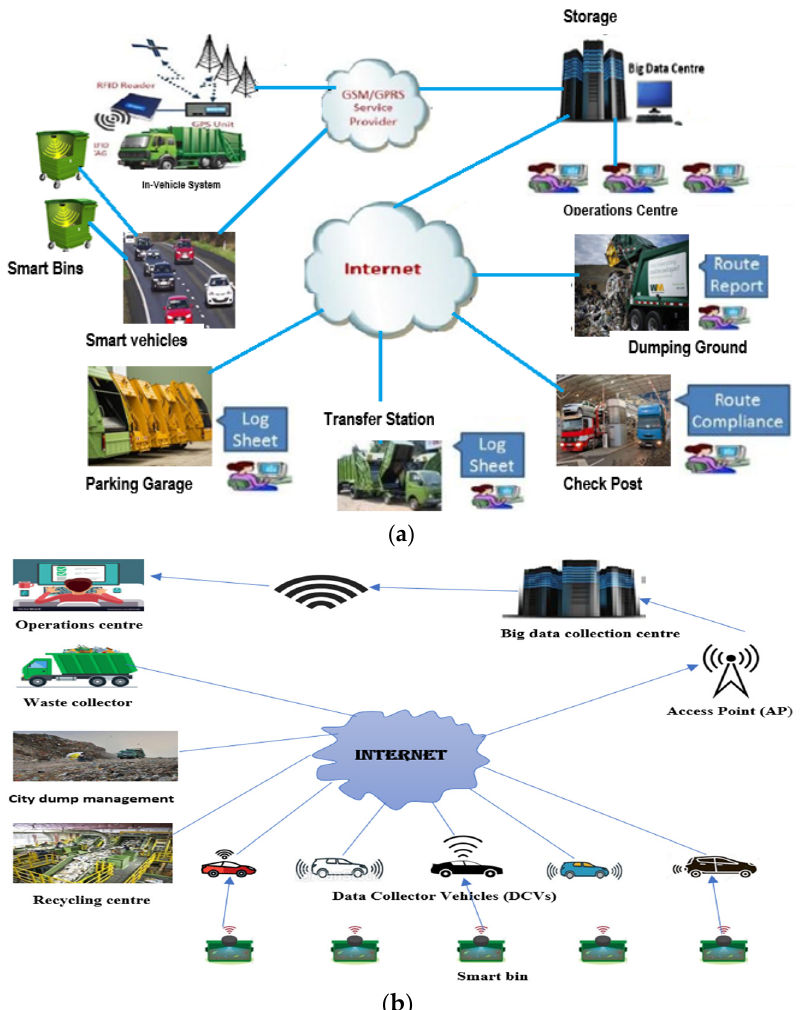
Figure 1. An IoV-based network model for smart city waste management. ( a ) An overview of Internet of Vehicles smart city waste management. ( b ) A model showing data collection for SC waste management.